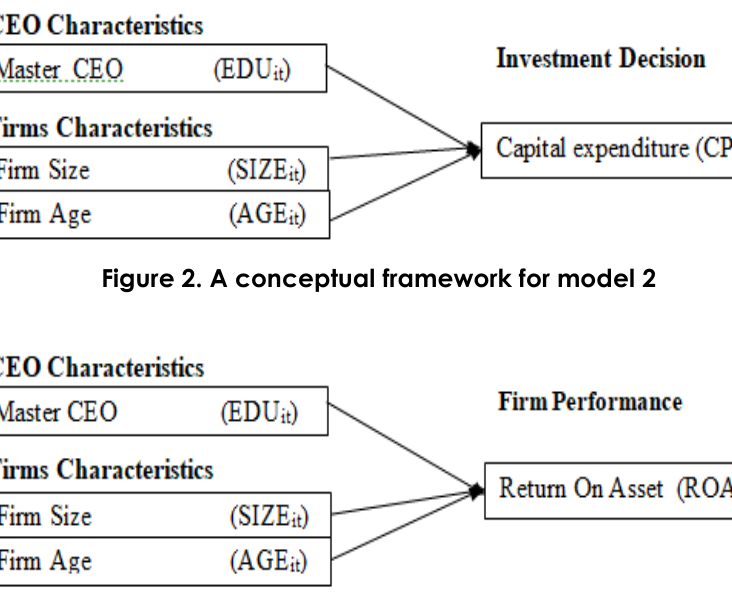
Figure 3. A conceptual framework for model